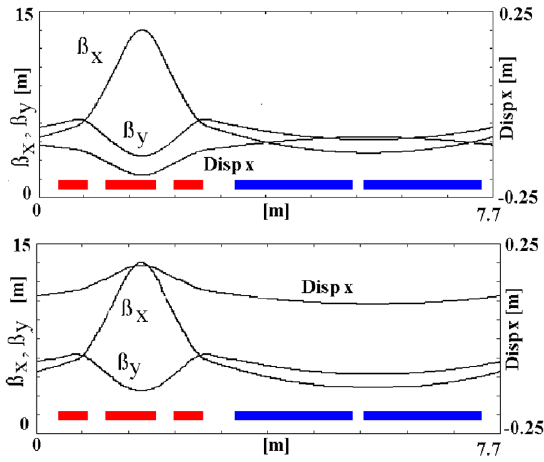
FIG. 15. (Color) Twiss functions and dispersion of the periodic cells in the return ring. Inward cells (upper diagram), outward cell (lower diagram). Bars illustrate magnets (red short quads, long blue